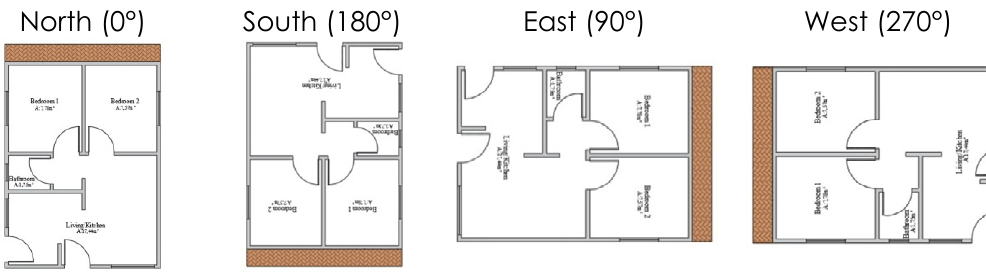
Figure 4. Variation of the embedded earth-sheltered wall orientation.